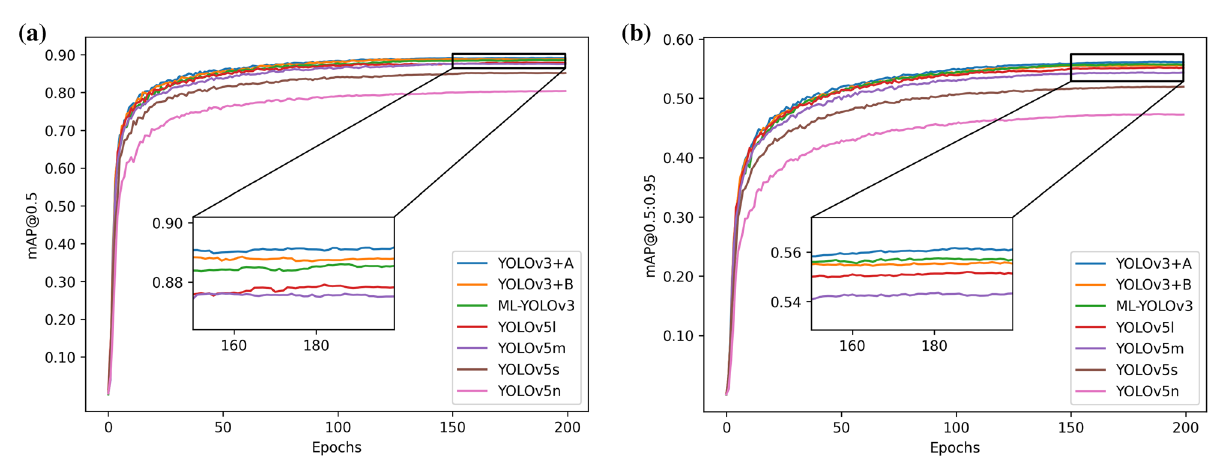
Figure 14. The comparison results of our improvement and YOLOv5s, YOLOv5n, YOLOv5l and YOLOv5l in terms of the detection